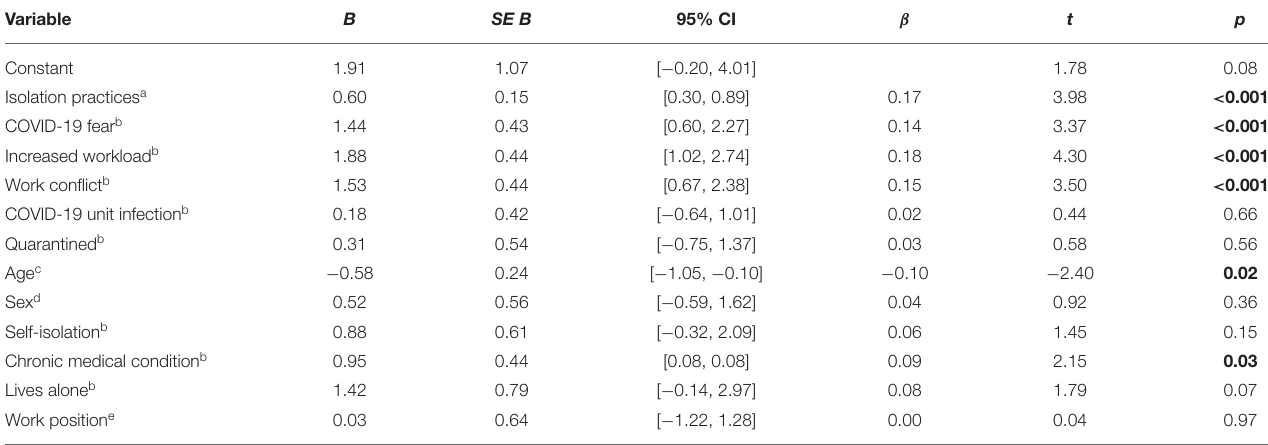
TABLE 4 | Multiple linear regression analysis for worker variables predicting PHQ-9 depression score. Variable B SE B 95% CI β t p Constant